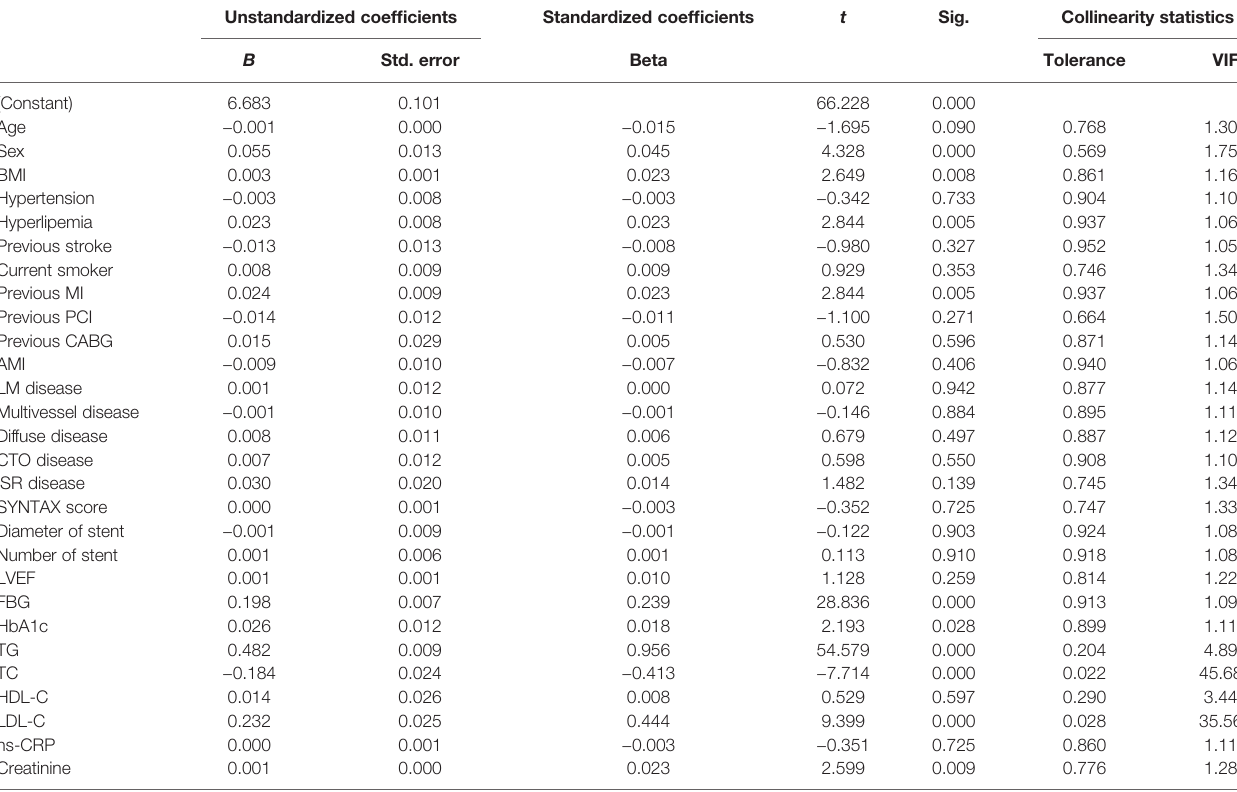
TABLE 2 | Collinearity analysis of baseline data with TyG index. Unstandardized coef fi